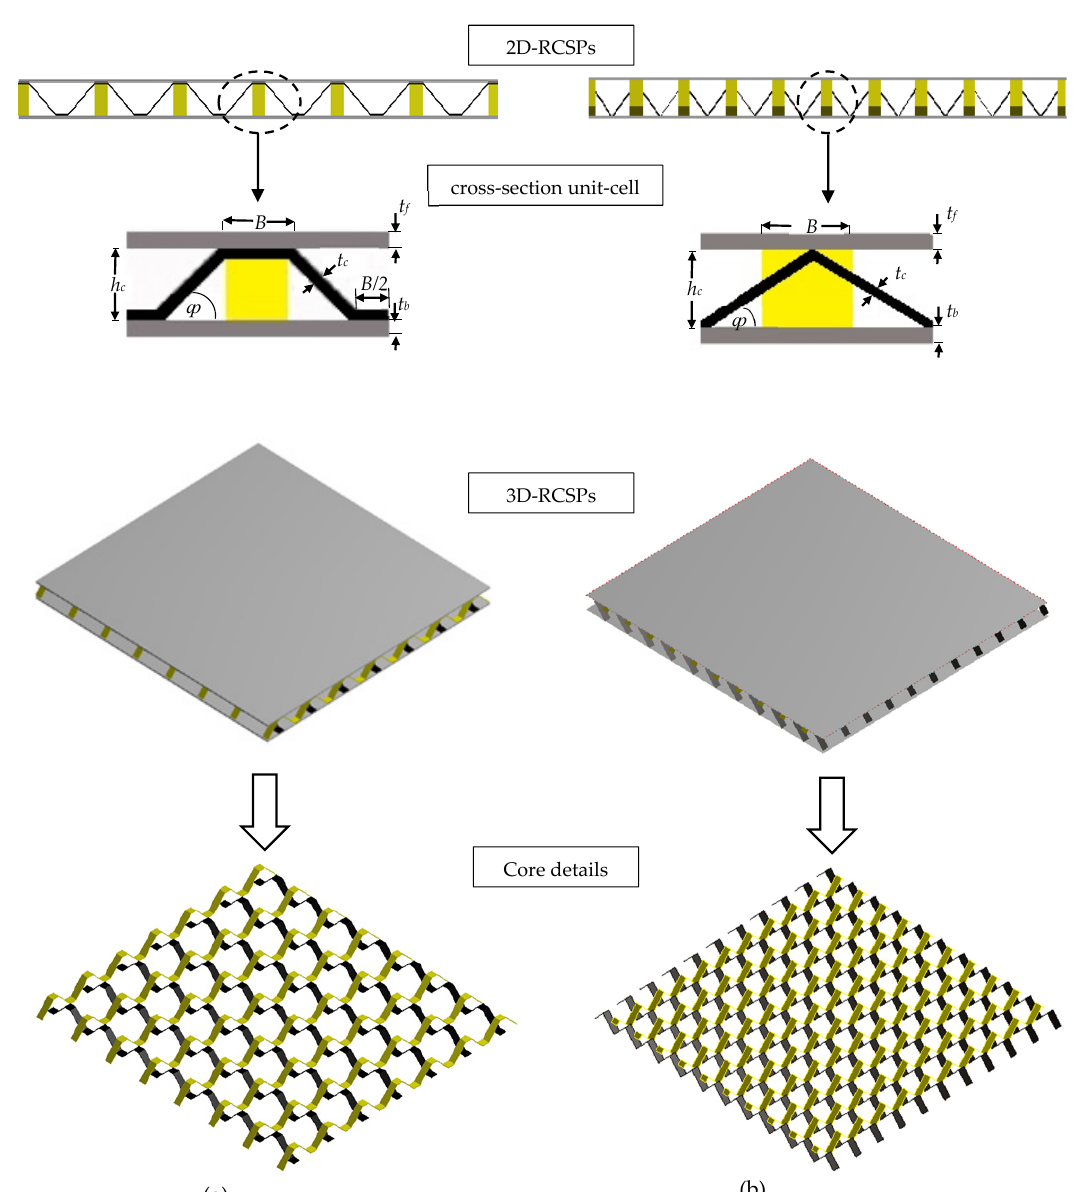
Figure 5. Schematic and inner core configuration of the ribbon core sandwich structures. ( a ) Trapezoidal corrugated ribbon core (TZRC)-panel. ( b ) Triangular ribbon corrugated core